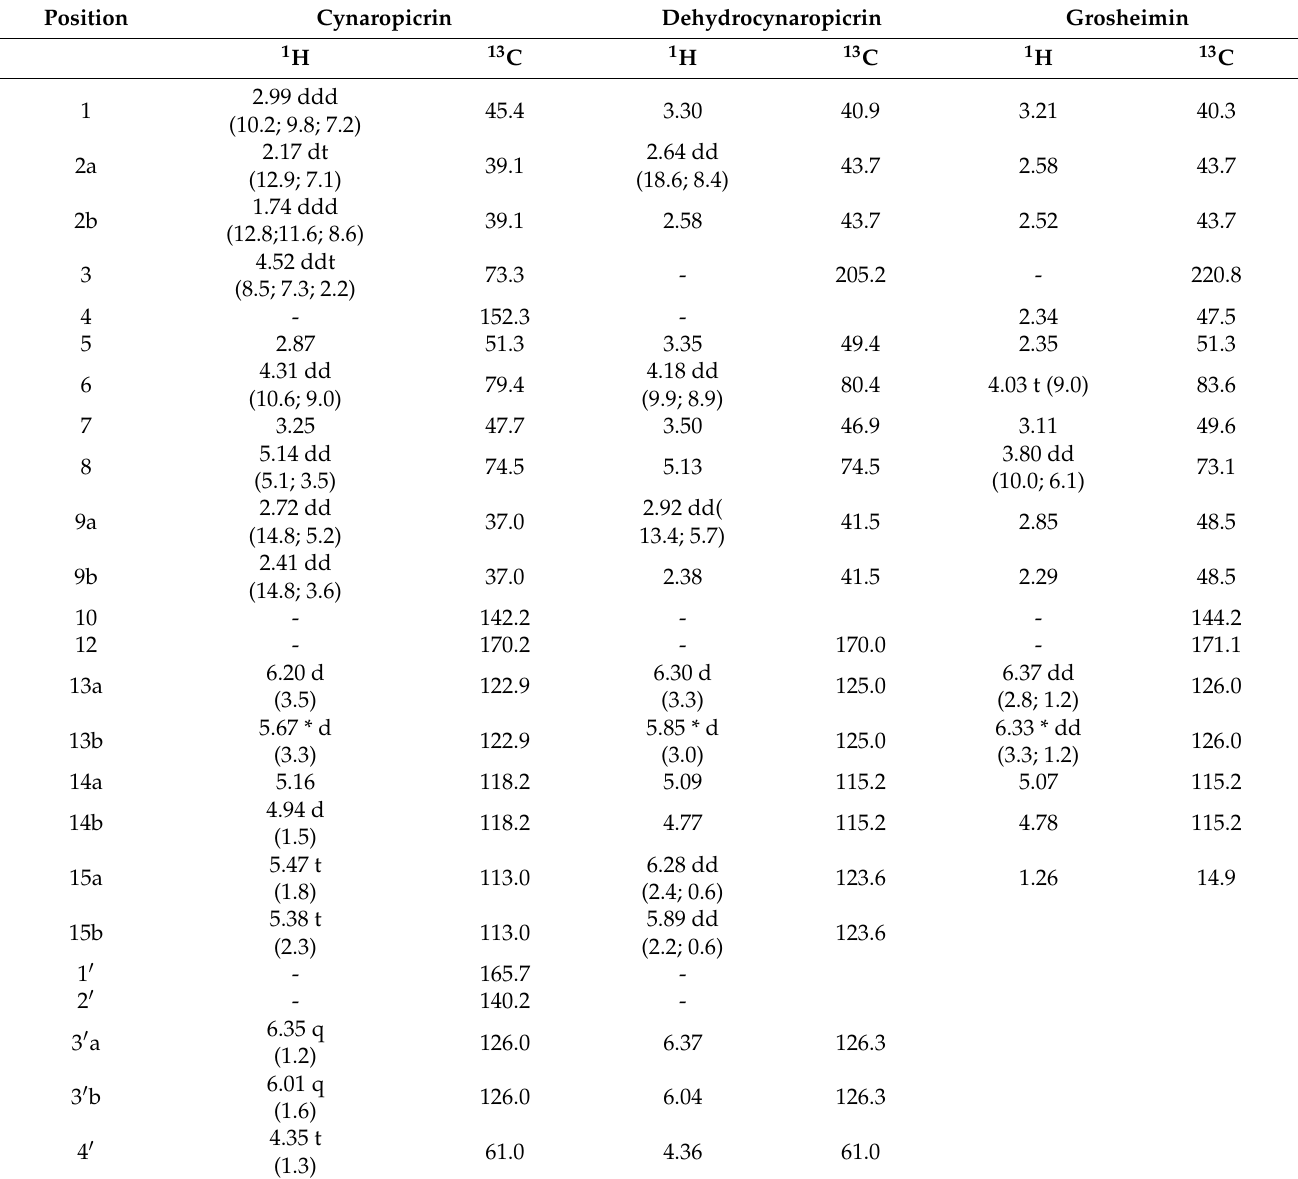
1 H- and 13 C NMR data of sesquiterpene lactones in globe artichoke